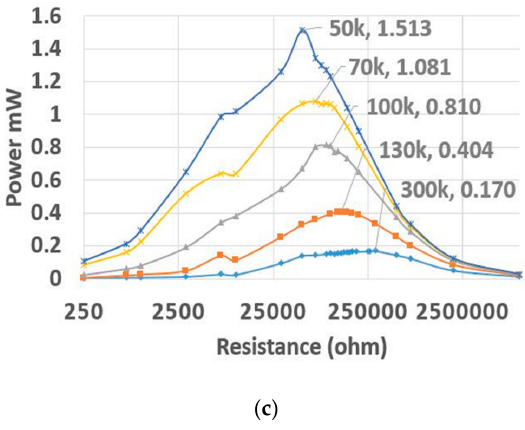
( c ) Figure 12. E ff ect of increasing the rotation speed on output power using di ff erent planet cover numbers: Figure 12. Effect of increasing the rotation speed by using different planet cover numbers: ( a ) one ( a ) one planet, ( b ) two planet covers and ( c ) four planet covers. planet, ( b ) two planet covers and ( c ) four planet covers.